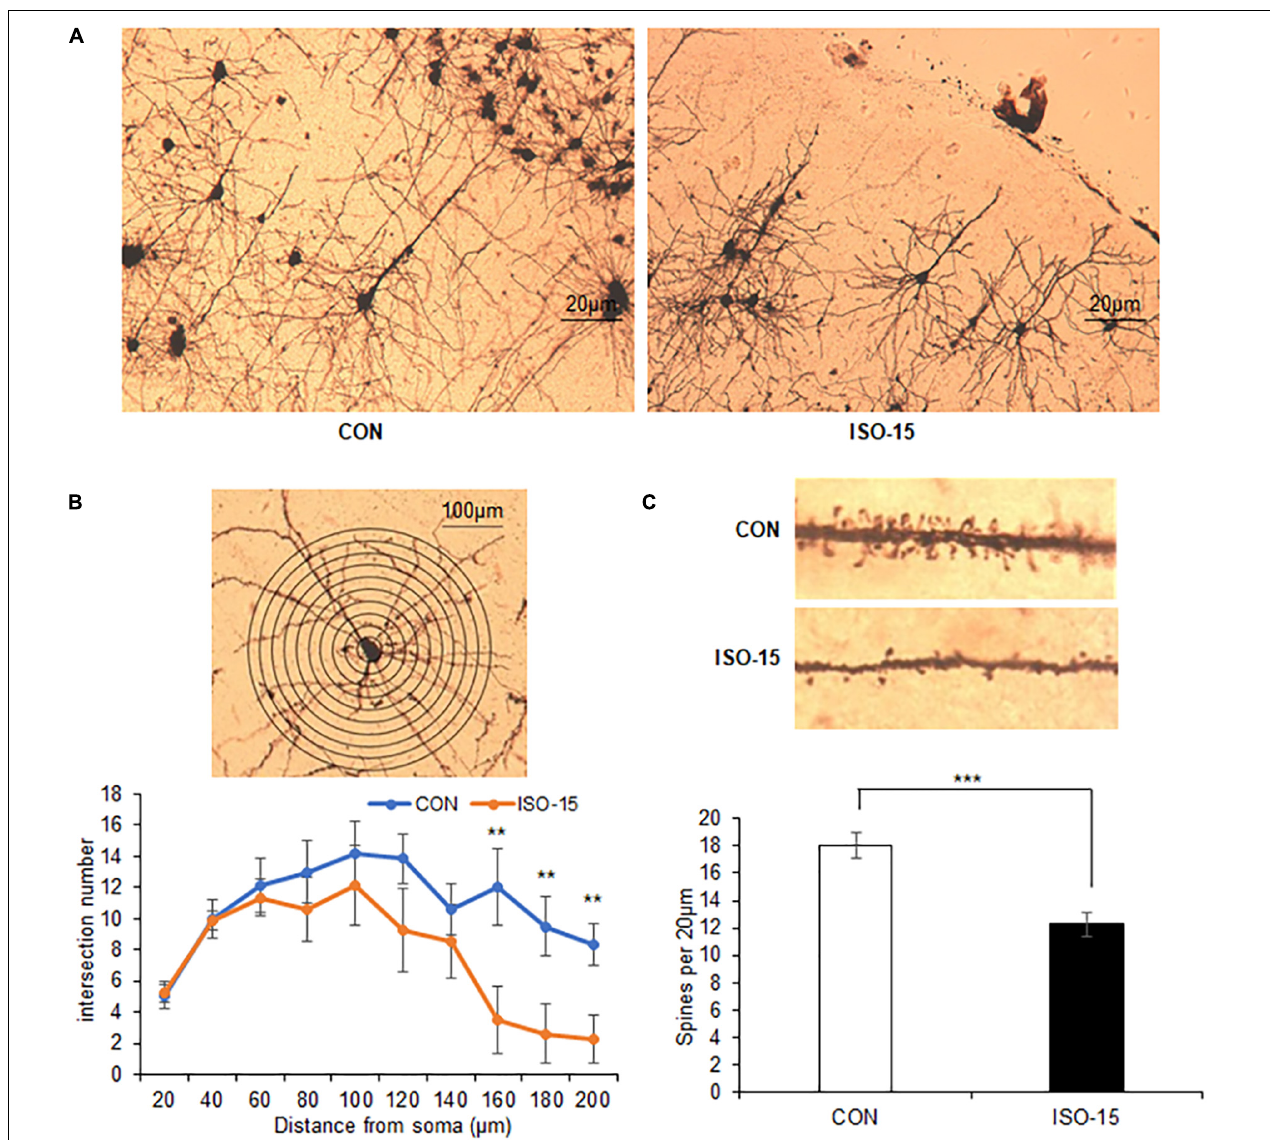
FIGURE 3 | The intersection number and spine density of the neuron in the cortex were reduced in isoflurane-exposed aged mice. (A) The Golgi staining picture to show neuron in the cortex in different groups. (B) The number of intersections at 150–200 µ m from the cell soma was reduced in the cortex in the ISO-15 group compared with the CON group ( n = 6, ** p < 0.01). (C) The spine density was reduced in the cortex in the ISO-15 group compared with the CON group ( n = 6, *** p <